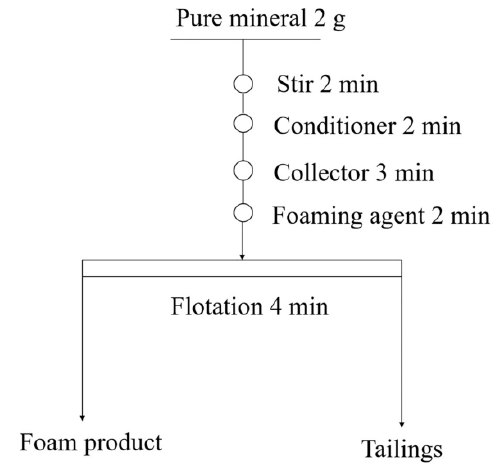
Figure 2. Flowchart of the flotation tests.